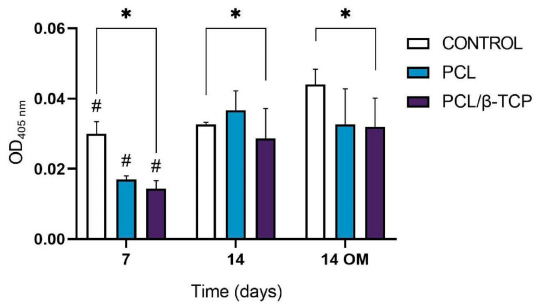
Figure 8. Alizarin Red quantification assay of ah -BM-MSCs seeded on PCL and PCL/ β -TCP scaffolds after 7 and 14 days of culture. Cells seeded on plastic (TCPs) were taken as the positive control. Results are shown as a function of optical density (OD) units. # Significant differences between the marked group at different time periods ( p > 0.05). * Significant differences between the bracketed groups at the same time period.